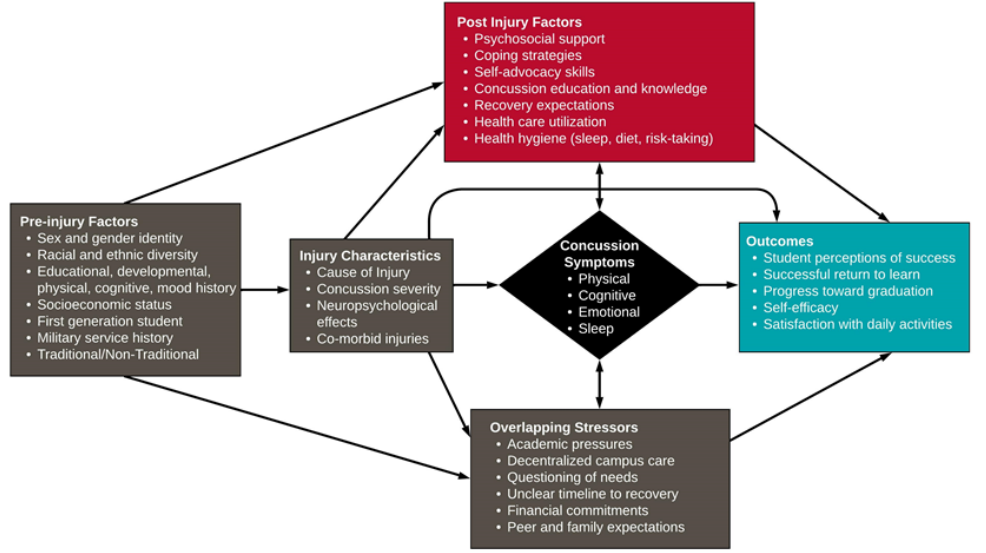
Figure 1. Neurobiopsychosocial model of concussion, adapted to reflect the needs and experiences of postsecondary students. SUCCESS targets modifiable post-injury factors in red, and is proposed to result in improved concussion, academic, and psychosocial outcomes shown in blue (adapted with permission from Yeates, 2010 [36] and from Polinder et al., 2018 [37] through the Creative Commons Attribution License).